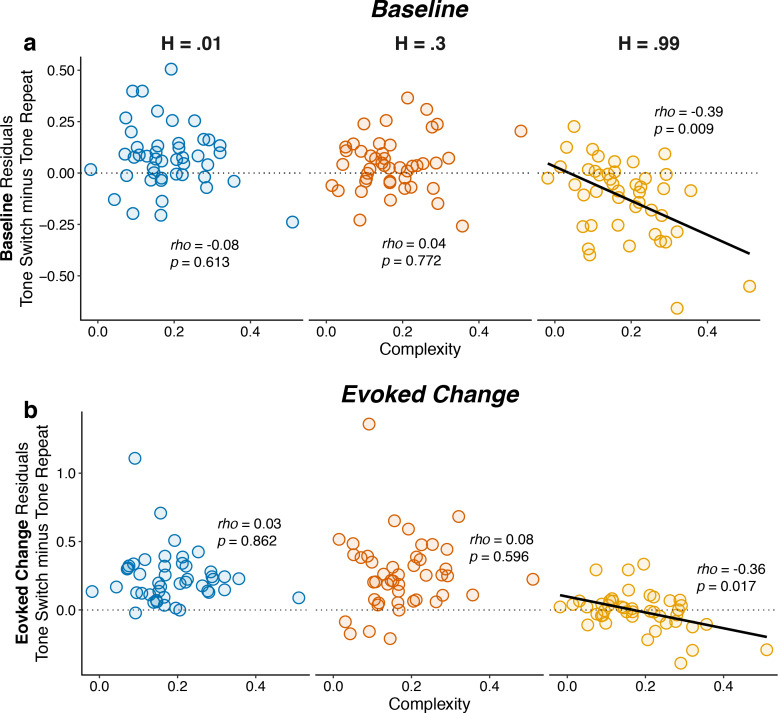
Individual differences in belief-updating complexity were reflected in within-hazard modulations of both baseline and evoked pupil diameter in the high hazard-rate condition that required a dissociation of top-down expectations from bottom-up stimulus changes.The two panels show (a) baseline and (b) evoked changes in pupil responses on tone switch versus repeat trials as a function of belief-updating complexity. Pupil measurements were computed as residuals from a linear model that accounted for nuisance variables including the baseline pupil diameter (for evoked changes) and the evoked change in pupil diameter from the previous trial (Equation 14). Points indicate data from individual subjects. Lines are linear fits for cases for which H0: Spearman correlation coefficient (rho, indicated for each data set)=0, p<0.05.